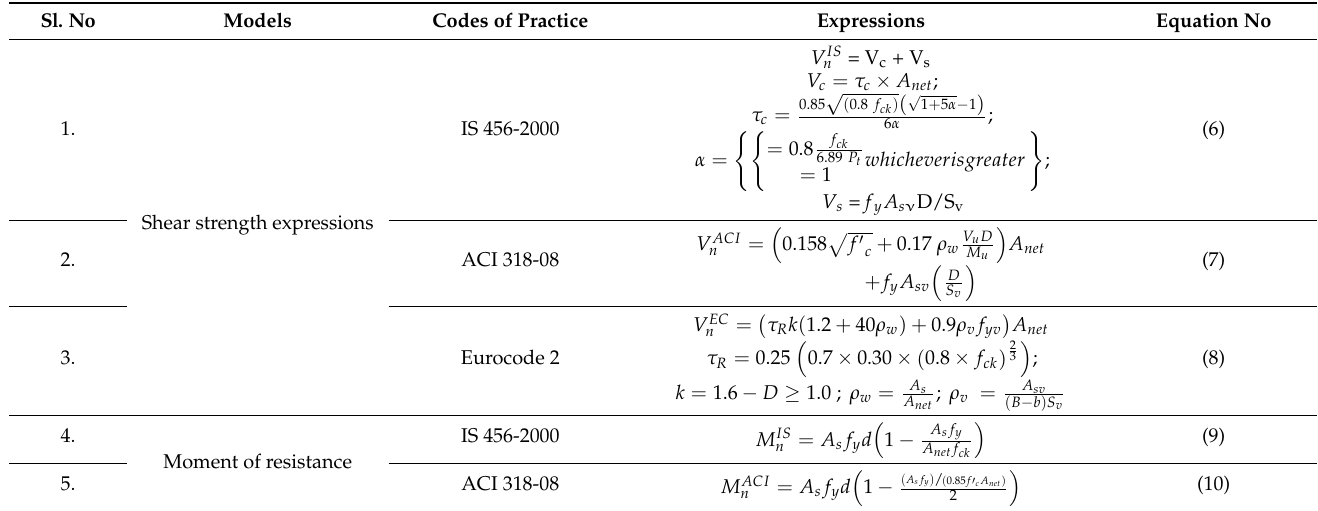
Table 4. Existing models to predict shear strength and moment of